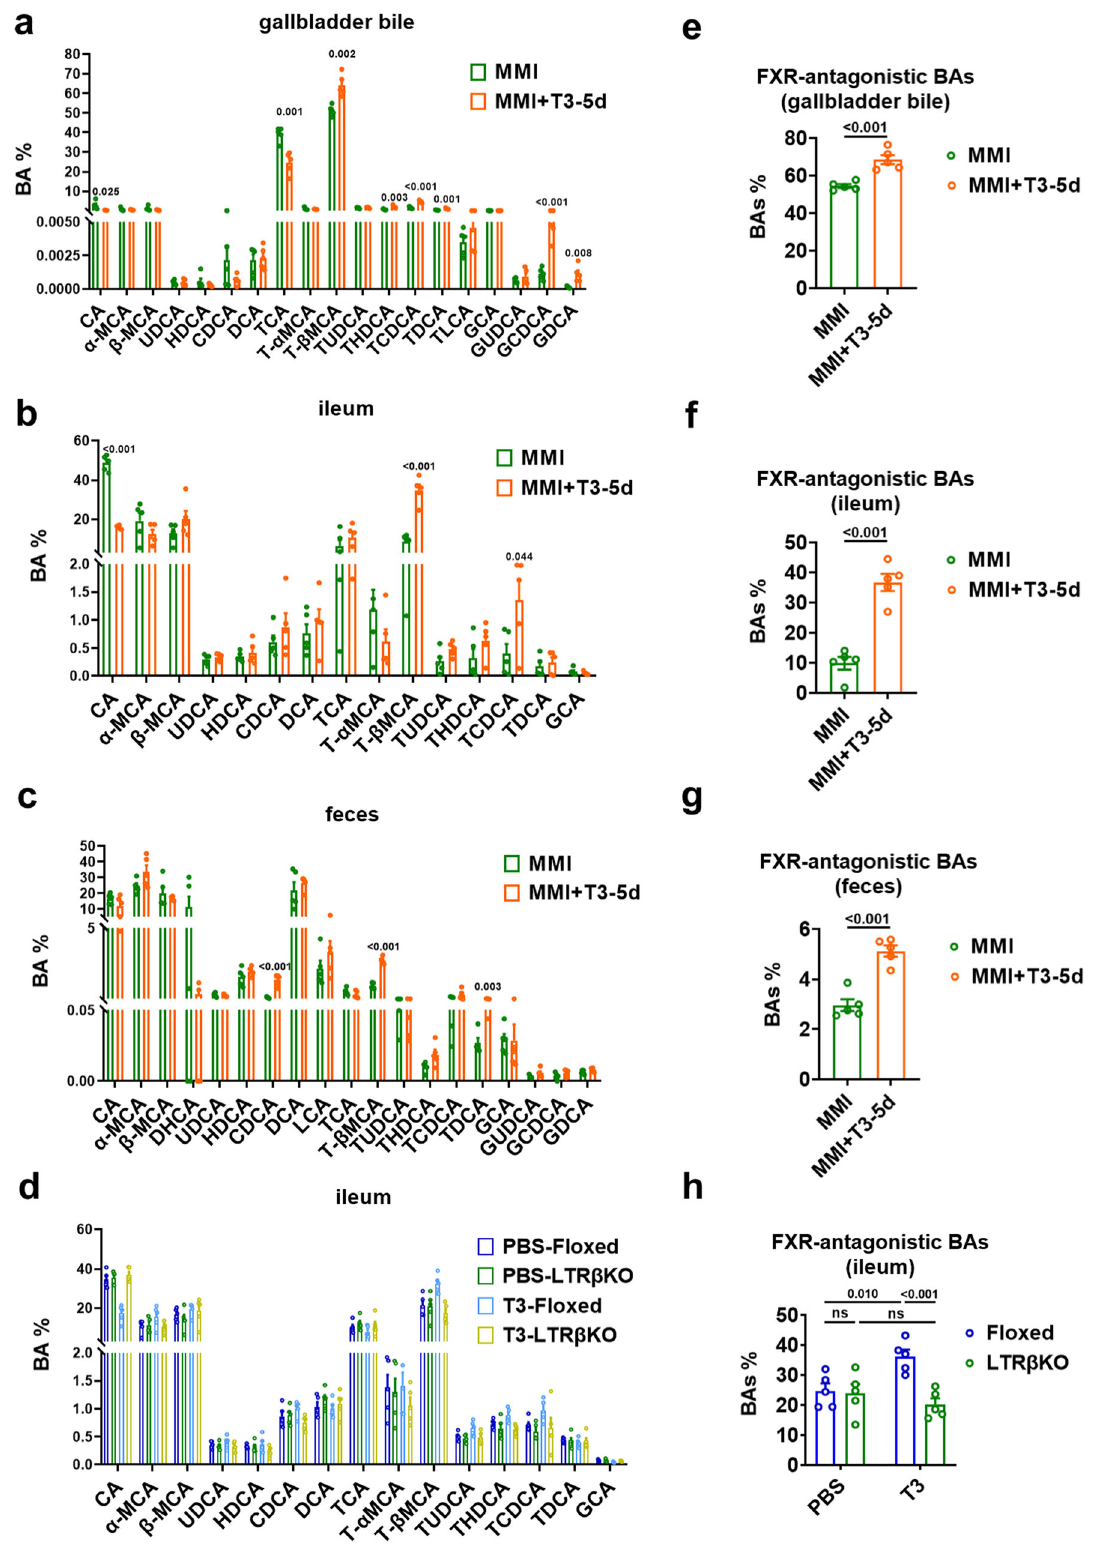
Fig. 5 | TH potentiates the production of non-12 α -OH FXR-antagonistic BAs. a – c The percentageof individual BAin the gallbladder bile ( a ), ileum ( b ) and feces ( c ) of MMI and MMI+T3-5d mice ( n =5). d The percentage of individual BA in the ileumofFloxedandLTR β KOmicetreatedwithPBSorT3for5days( n =5). e – g The percentage of non-12 α -OH FXR-antagonistic BAs, including T( α / β )MCA, (T/G)